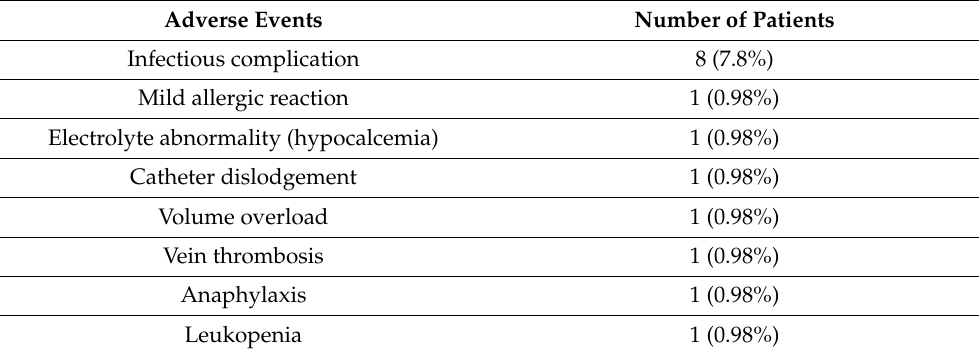
Table 3. Reported adverse